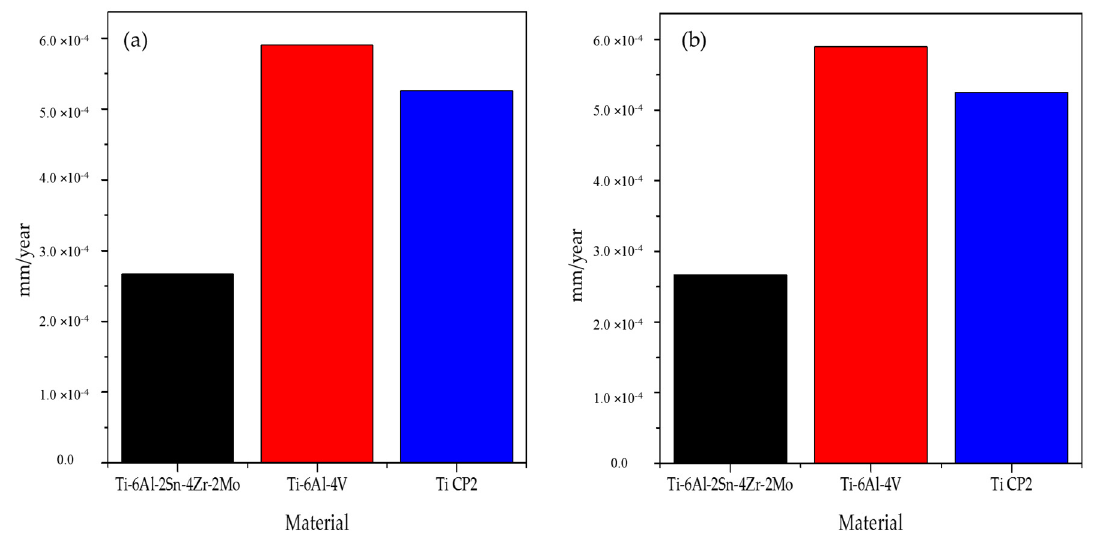
Figure 4. Corrosion rates in ( a ) NaCl and ( b ) H 2 SO 4 Solutions.